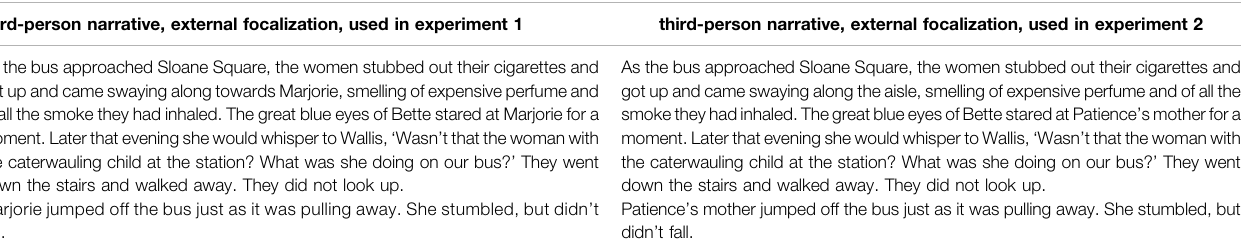
TABLE 4 | Exemplary comparison of the text stimuli used in Experiments 1 and 2. third-person narrative, external focalization, used in experiment 1 third-person narrative, external focalization, used in experiment 2